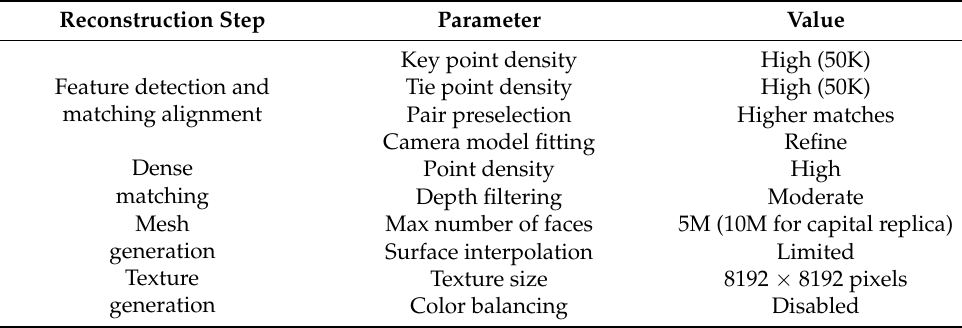
Table 3. Processing parameters of image-based photogrammetric